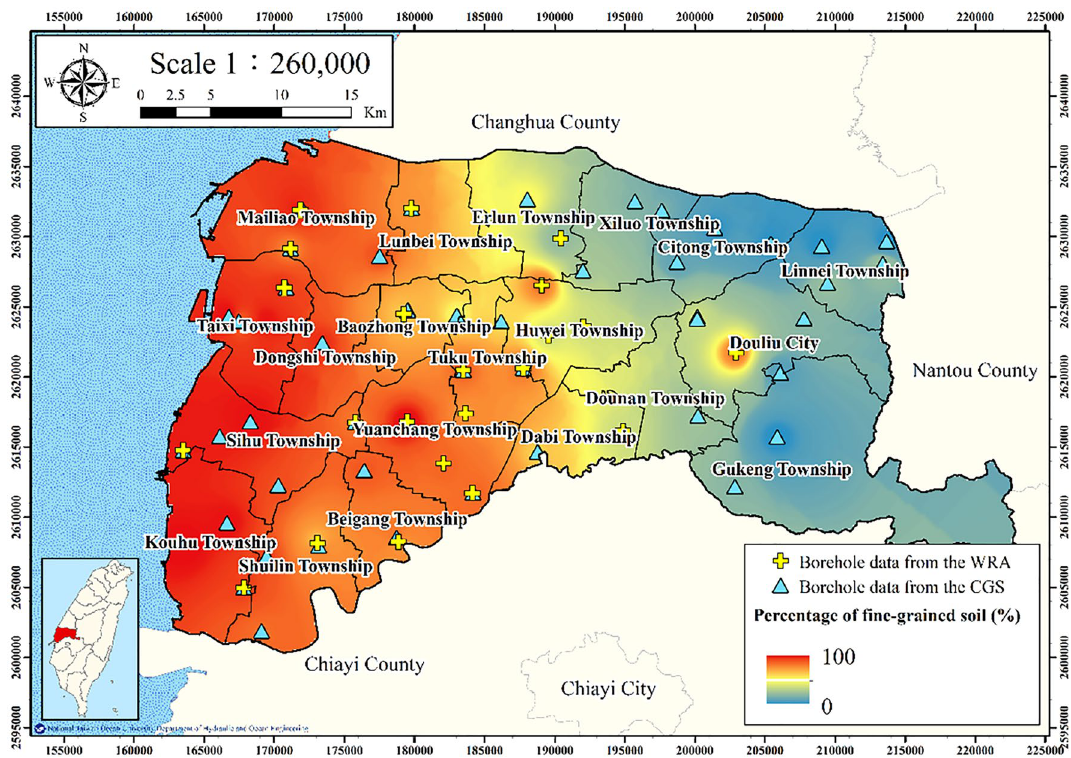
Figure 6. Percentage of fine-grained soil in Yunlin County. This figure was created using ArcGIS 10.6.1 software.